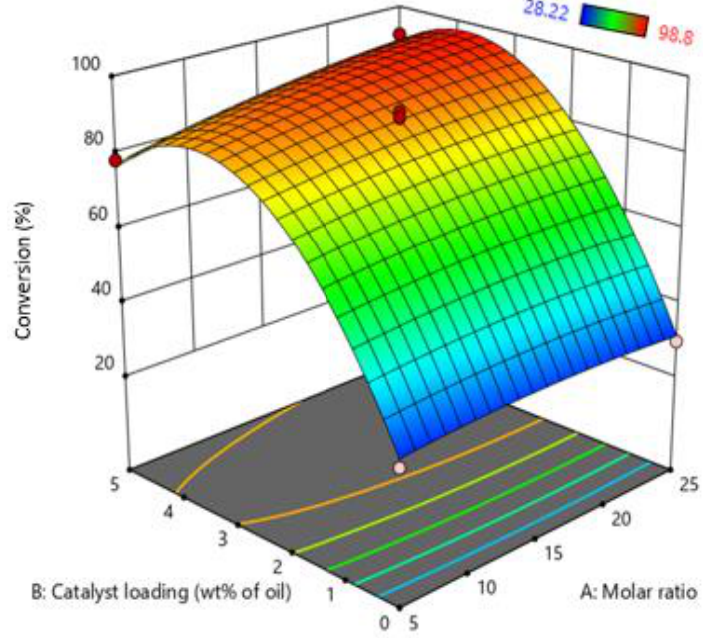
Figure 3. Effect of molar ratio (oil: MeOH) and catalyst loading on biodiesel production.